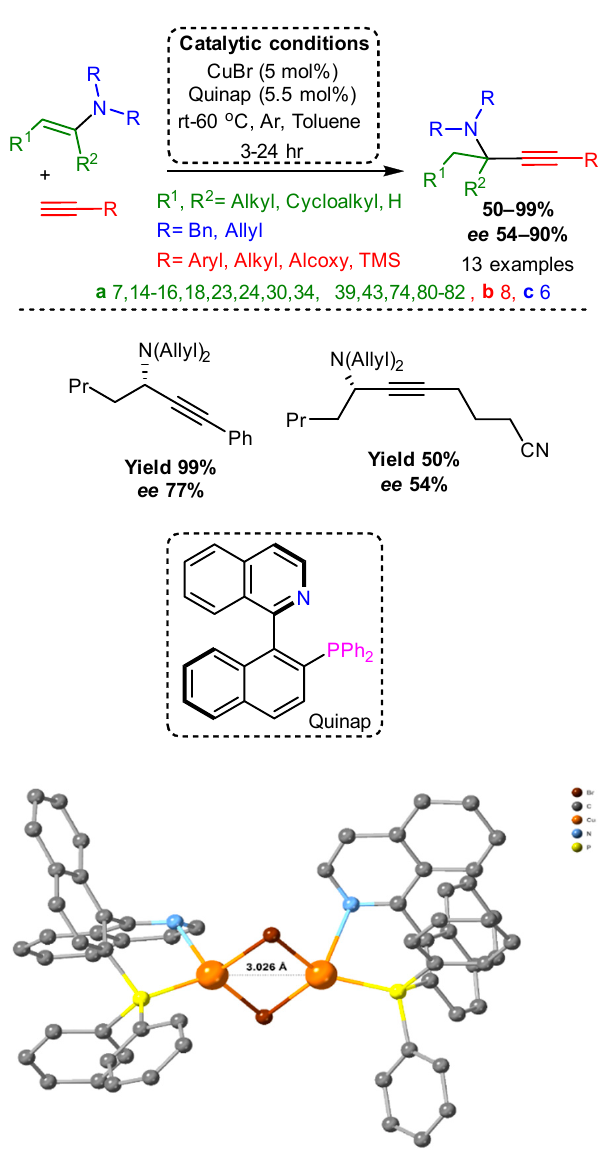
Scheme 54. ( upper ) Copper/Quinap-catalyzed the enantioselective synthesis of PAs by adding alkynes to enamines. ( lower ) The crystallographically characterised